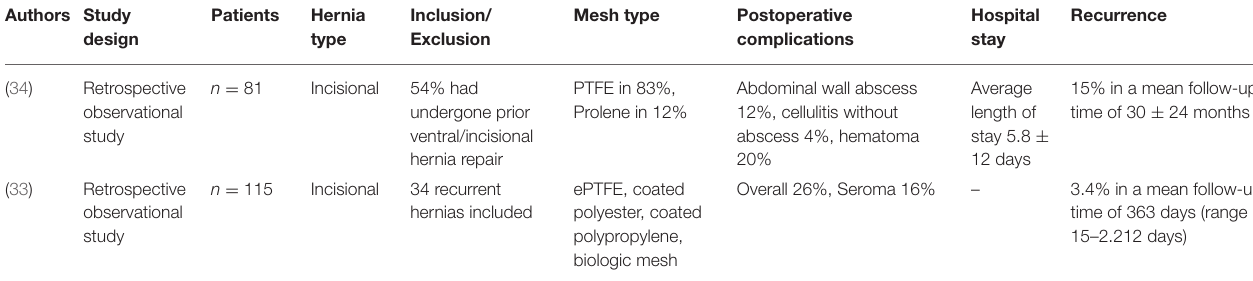
TABLE 4 | Open intraperitoneal onlay mesh with defect closure by sublay-technique for incisional hernia repair. Authors Study